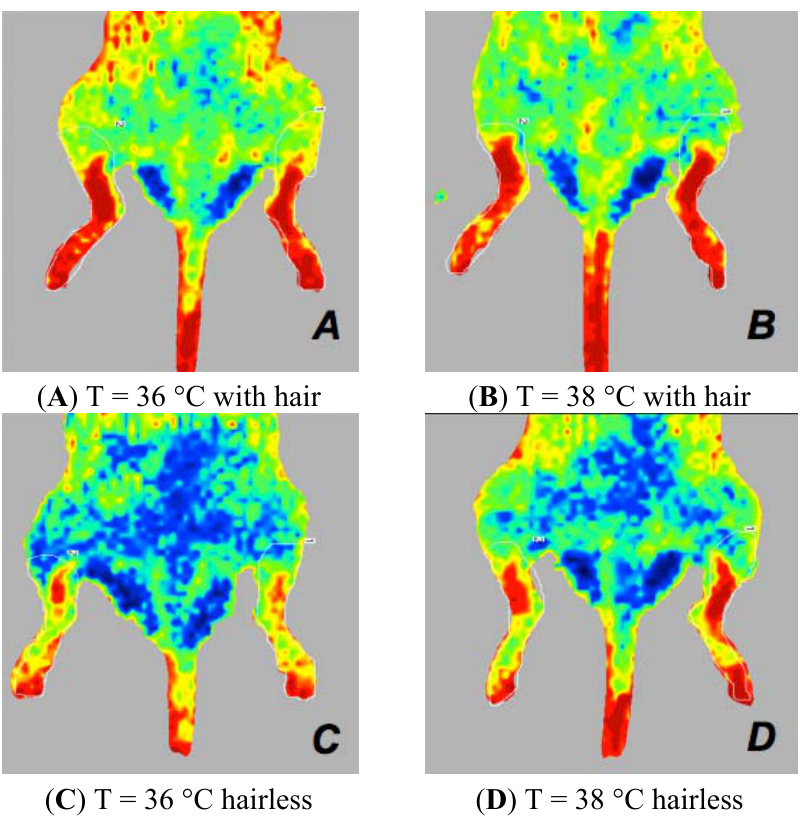
anaesthetised by injection. The perfusion values in mice with a body temperature of 38 °C are always higher (Figure 9). Figure 6. Laser Doppler images of the hind limbs of ARC and ARD mice positioned in the ventral decubitus position. Mice anaesthetised with isoflurane, both at 36 °C and 38 °C, with ARC depilation ( A , B ) have values of perfusion higher than those found under similar experimental conditions but with ARD depilation ( C , D ).